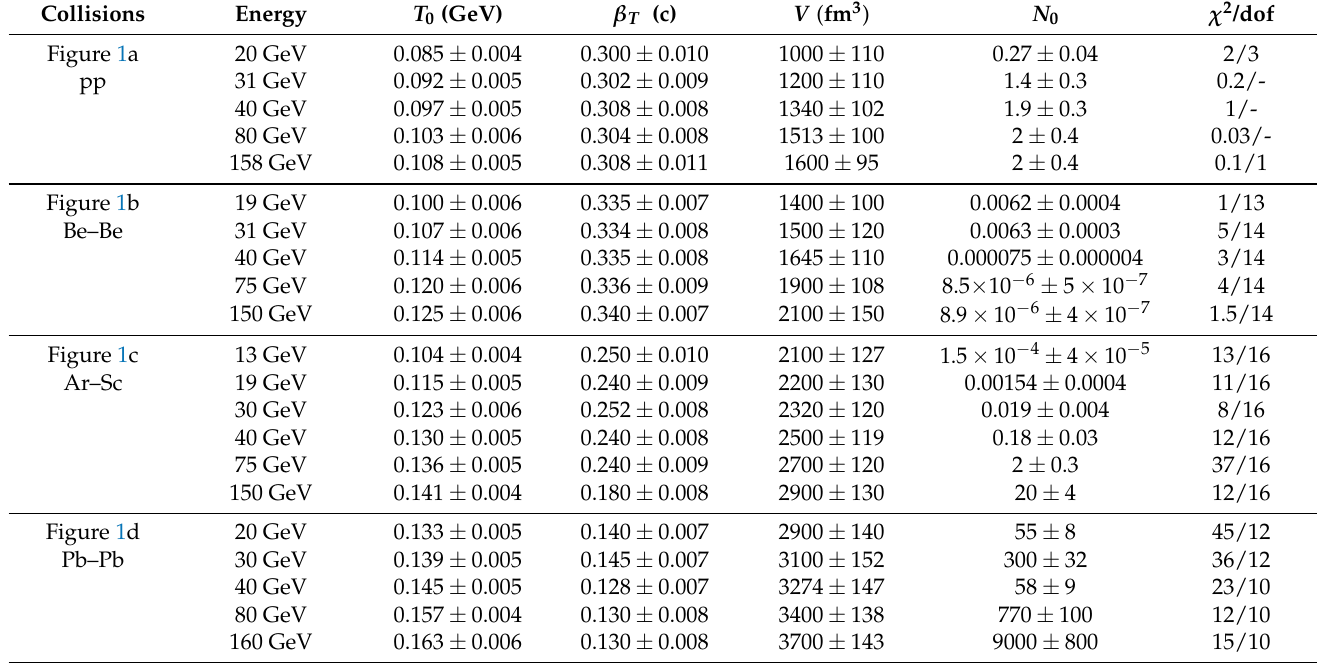
Table 1. List of the parameters. The “-” sign is used in some places instead of dof. In fact, it is not the fit result. If dof < 0, we use “-” instead of negative